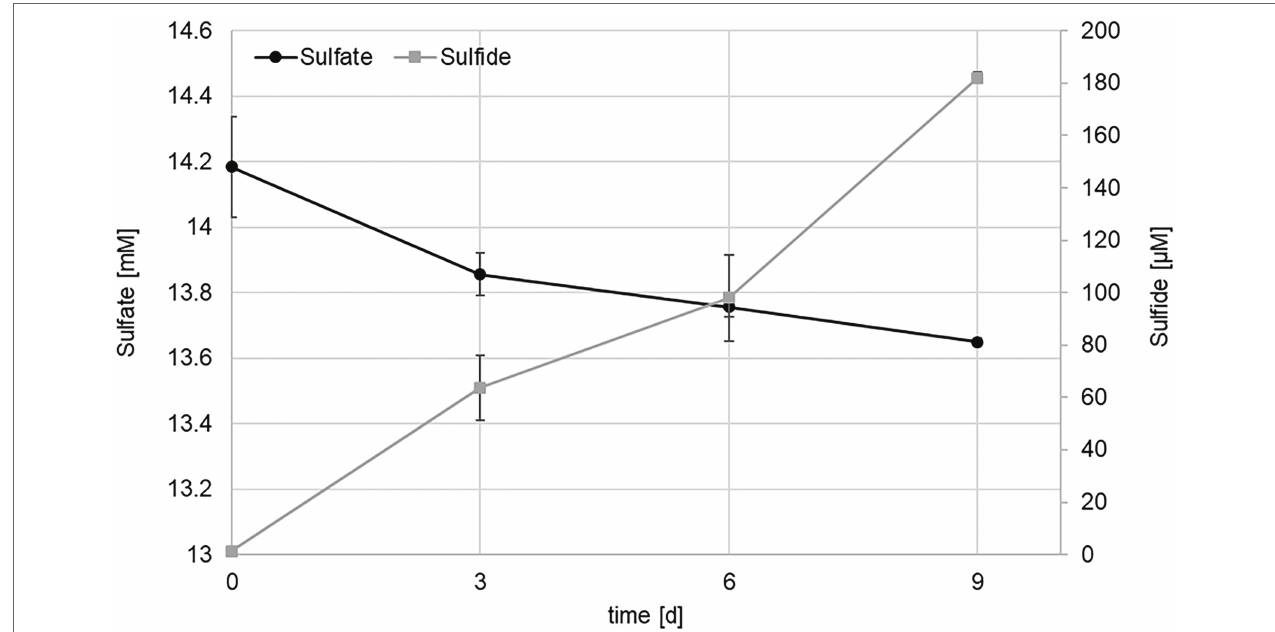
FIGURE 4 | Sulfate (black) and sulfide (gray) concentrations in cultures of strain KaireiS1 grown in MJ medium under a H 2 :CO 2 :He (2:20:78) atmosphere. Error bars indicate the standard deviations from three independent